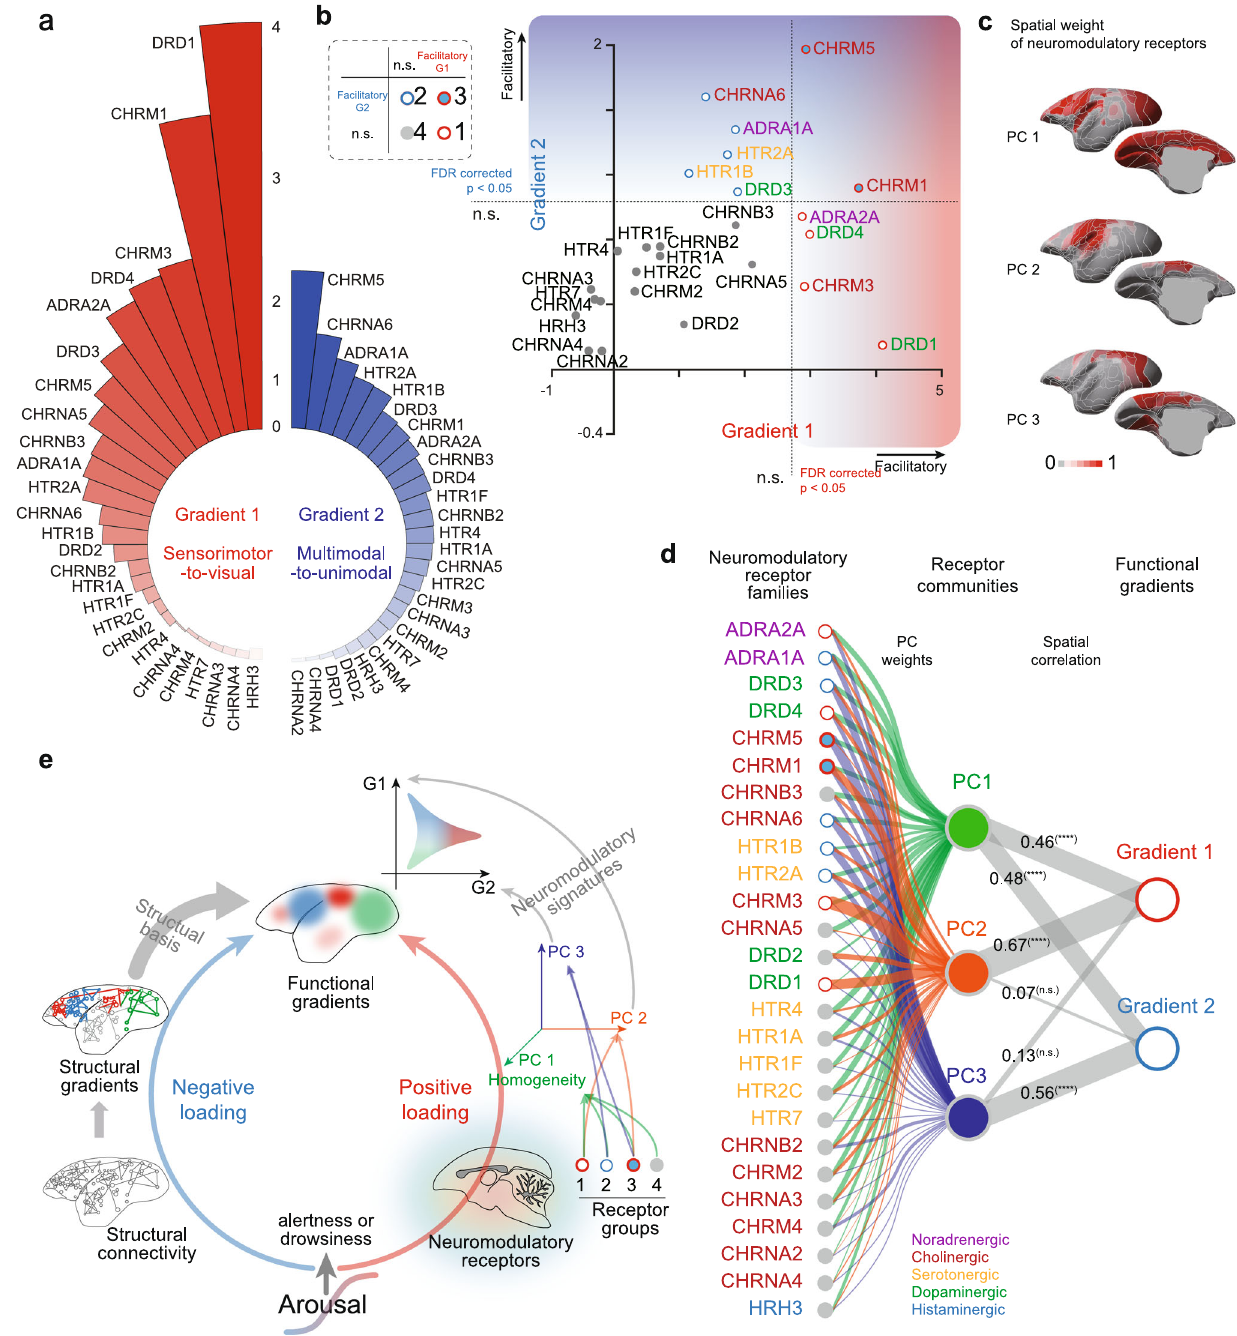
Fig. 6 | Receptor speci fi c neuromodulatory signatures of functional gradient dynamics. a The unique contribution on explained variance of fi rst two gradient dynamics for neuromodulatory receptor maps. The bar was ranked and scaled according to the meanexplainedvariance(%) of each receptormap. b Scatterplot of neuromodulatory receptors according to the unique contribution on explained variance of fi rst two gradient dynamics. The receptors were divided into four groups based on the statistical signi fi cance (FDR corrected p <0.05, right-tailed t - test). c Spatial maps for the fi rst three principal components of neuromodulatory receptors. d Associations between functional gradients and neuromodulatory receptor communities. The color rings of receptors were based on the inset in b .